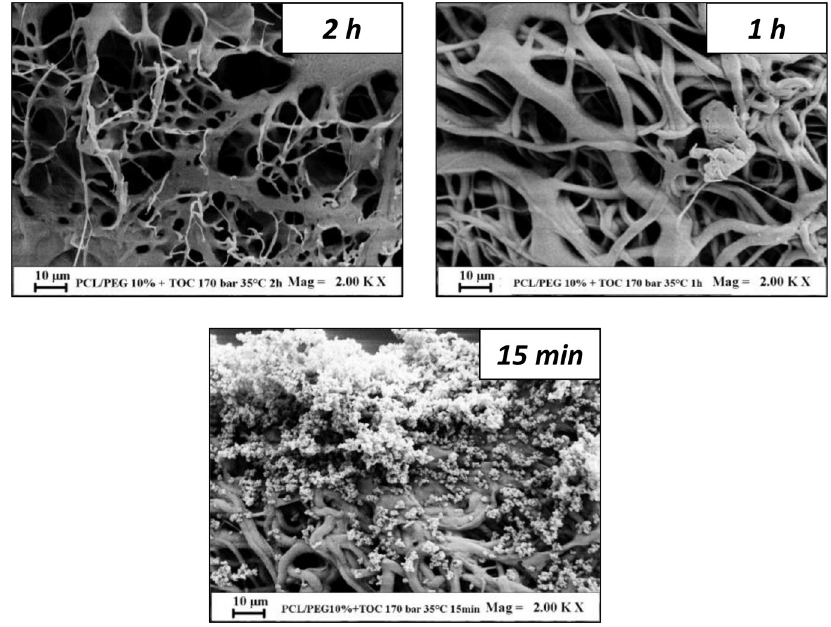
Figure 7. FESEM images of the electrospun fibers impregnated with alpha-tocopherol at 35 ◦ C and 170 bar and different impregnation times: 2 h,1 h, and 15